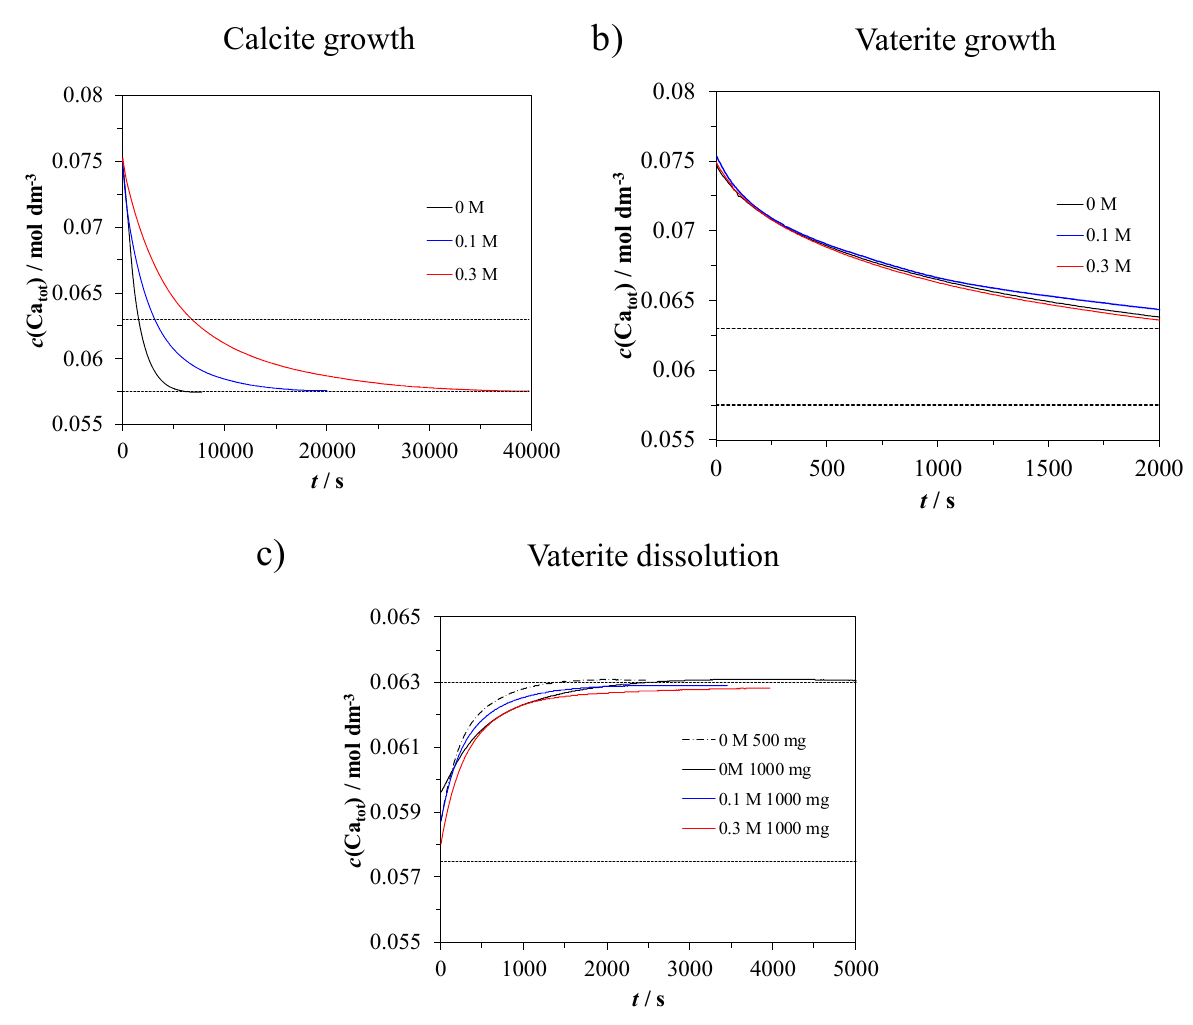
Figure 6. Progress curves, solution concentration vs. time of seeded growth of ( a ) calcite or ( b ) vaterite: c i (CaCl 2 ) = c i (NaHCO 3 ) = 0.1 mol dm − 3 and different concentrations of LiCl initially present in the systems. ( c ) Dissolution of vaterite was initiated in the undersaturated system: c i (CaCl 2 ) = c i (NaHCO 3 ) = 0.0575 mol dm − 3 . Initial mass concentrations of calcite and vaterite seed in the growth experiments were, γ (calcite) = 125 mg L − 1 and γ (vaterite) = 125 mg L − 1 while in dissolution experiments γ (vaterite) = 500 or 1000 mg L − 1 . Table 1. Calculated rate constants of calcite and vaterite grown in the systems, c i (CaCl 2 ) = c i (NaHCO 3 ) = 0.1 mol dm − 3 and vaterite dissolution in the undersaturated system: c i (CaCl 2 ) = c i (NaHCO 3 ) = 0.0575 mol dm − 3 , and different concentrations of LiCl initially present in the systems. Predominant mechanisms are growth on dislocation ( k ln ) and diffusion of ions away from to surface into the bulk of solution ( D